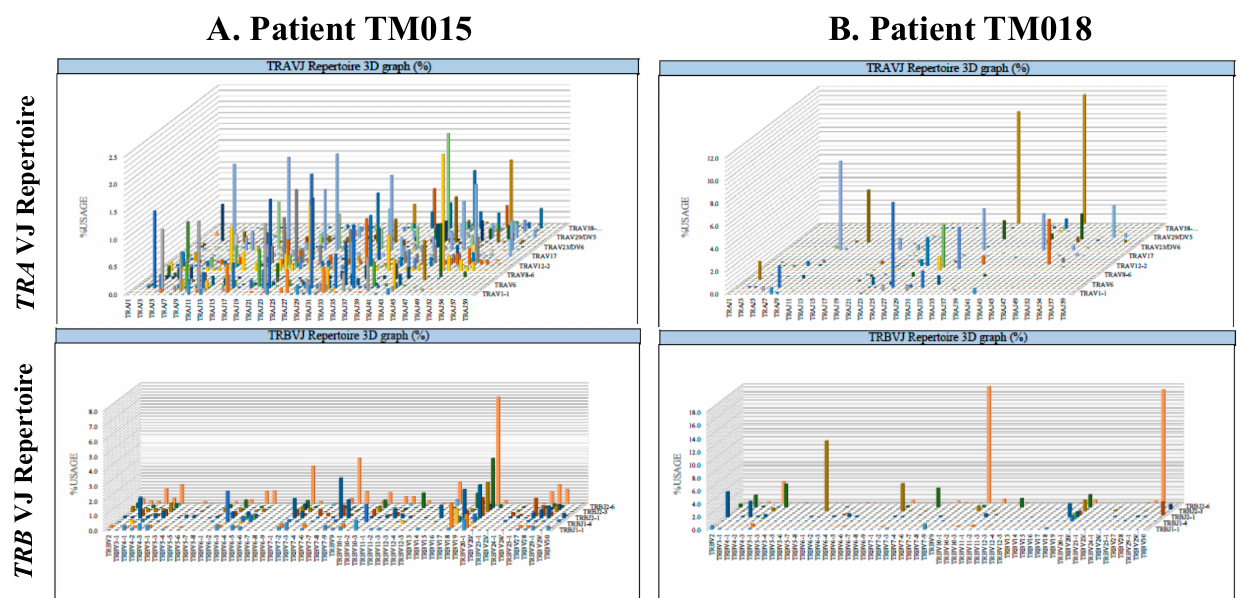
Figure 1. The typical results of the T-cell receptor α ( TRA ) and TCR B ( TRB ) repertoires, each of esophageal squamous cell carcinoma (ESCC) treated by surgery only ( A ) and ESCC relapsed after definitive chemoradiation therapy (CRT) ( B ). The TRA repertoire and TRB repertoire are shown in the upper and lower panels, respectively. Three-dimensional graphs indicate the combination of using TRAJ on the x-axis and TRAV on the y-axis or of TRBV on the x-axis and TRBJ on the y-axis, with the frequency (percentage) of each clone on the z-axis. Oligoclonal expansion is observed more in ESCC relapsed after definitive CRT ( B ) than in ESCC treated by surgery alone ( A ).